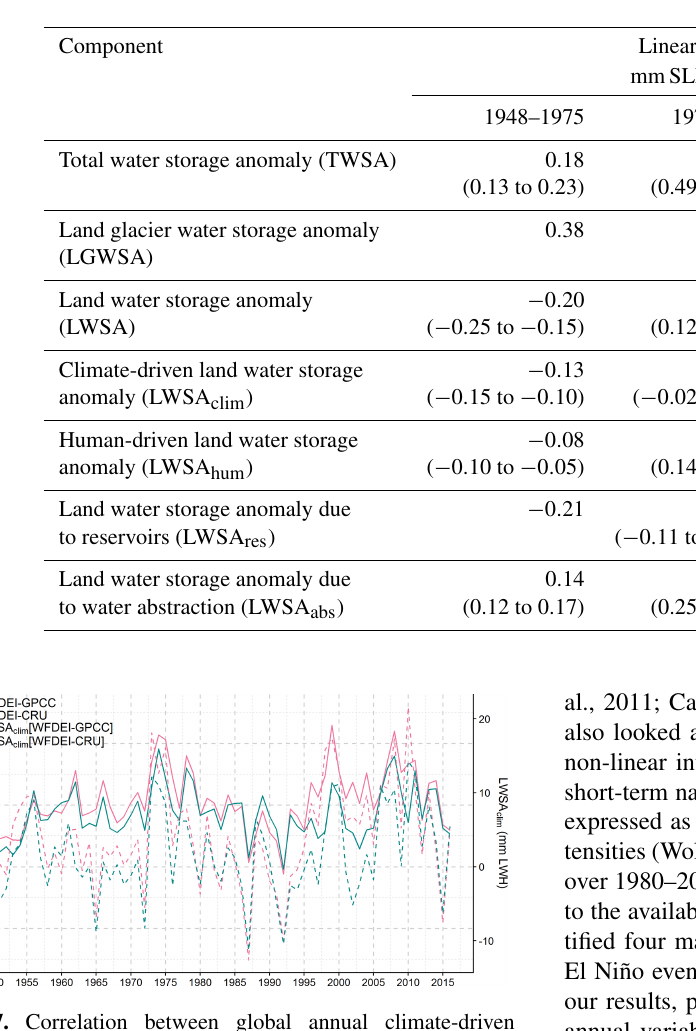
Table 4. Linear trends of the contribution of TWSA, LGWSA, LWSA, LWSA clim , LWSA hum , LWSA res and LWSA abs to ocean mass change over 1948–1975, 1976–2002 and 2003–2016. Positive trends translate to ocean mass gain, whereas negative trends translate to ocean mass